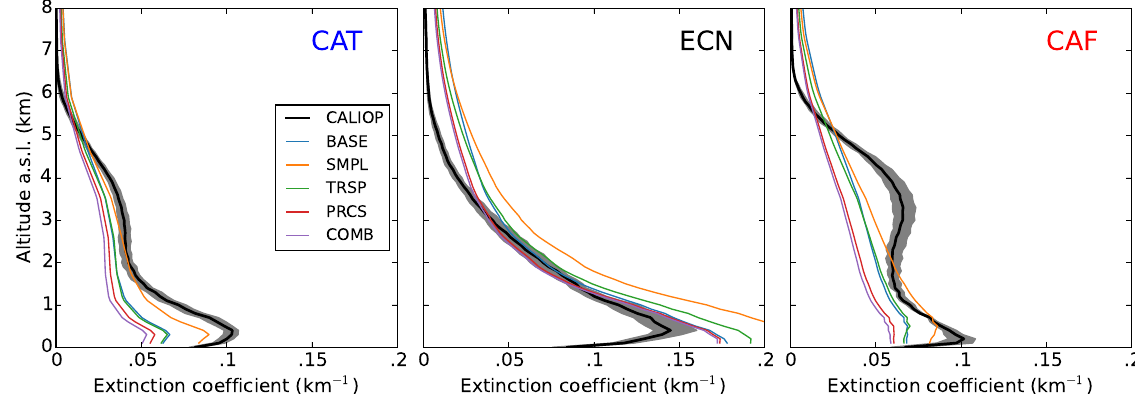
Figure 10. Summer (JJA) average extinction coefficient (km − 1 ) profiles for 2005 (models) and 2007–2009 for CALIOP observations in the central Atlantic (CAT), eastern China (ECN) and central Africa (CAF) regions as used in Koffi et al. (2012). The grey-shaded area indicates the spread between minimum and maximum seasonal values in the CALIOP